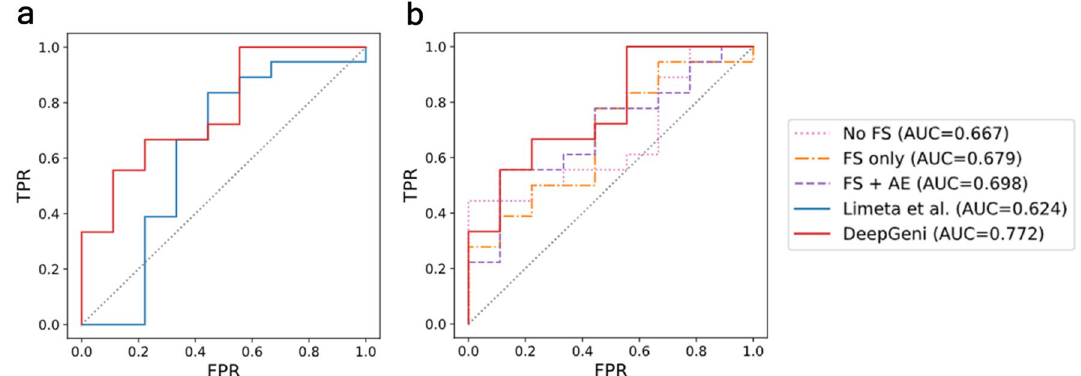
Figure 2. Receiver operating characteristics (ROC) curves of the best classifier for each method predicting ICI response. ( a ) Prediction performance comparison of DeepGeni and the state-of-the-art classifier (Limeta et al.). ( b ) Performance comparison of DeepGeni and alternative approaches using feature selection (FS) and/or autoencoder (AE, FS + AE) without DeepBioGen augmentations.